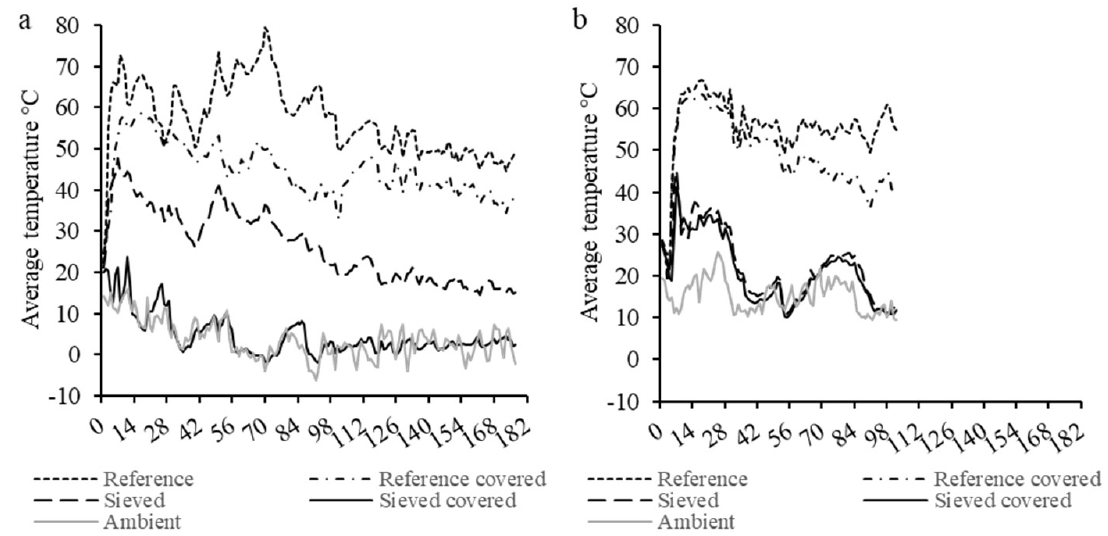
Figure 4. The average temperature during storage of wood chips in block 1 ( a ) and block 3 ( b ). 3.2. Moisture Content